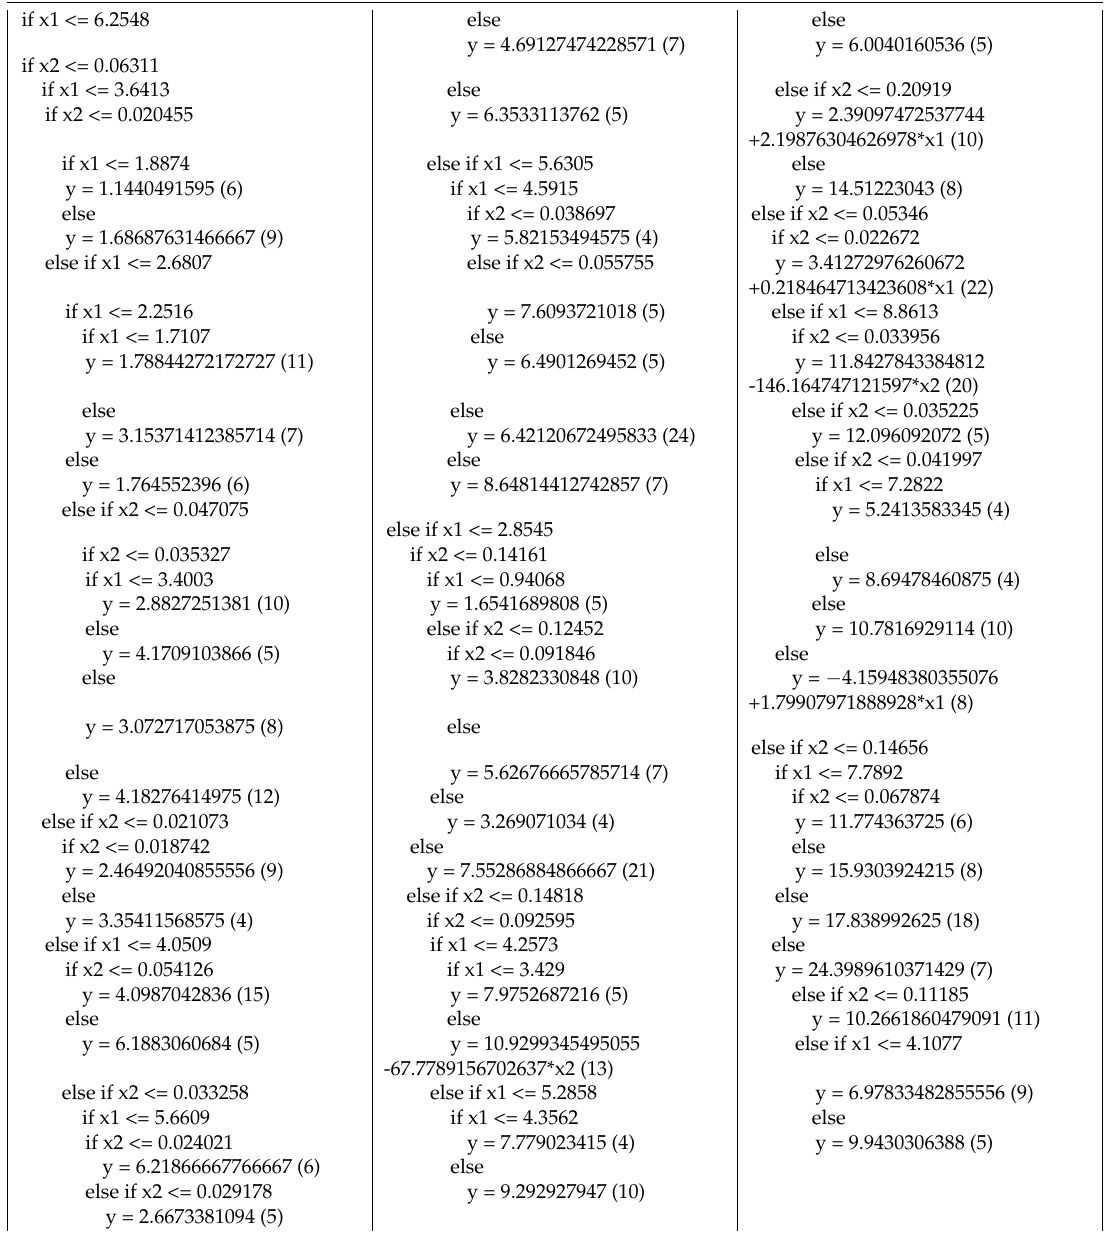
Table A2. Regression tree obtained from M5Tree for strain